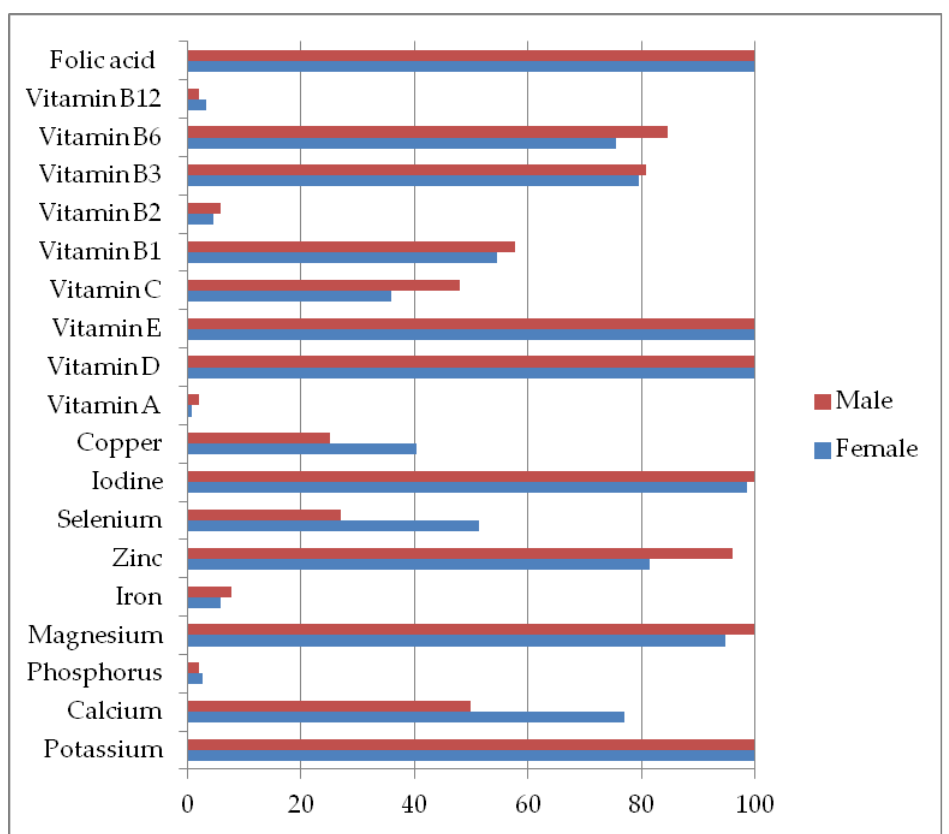
Figure 1. Percentage of participants not reaching the Dietary Reference Intakes for micronutrients.